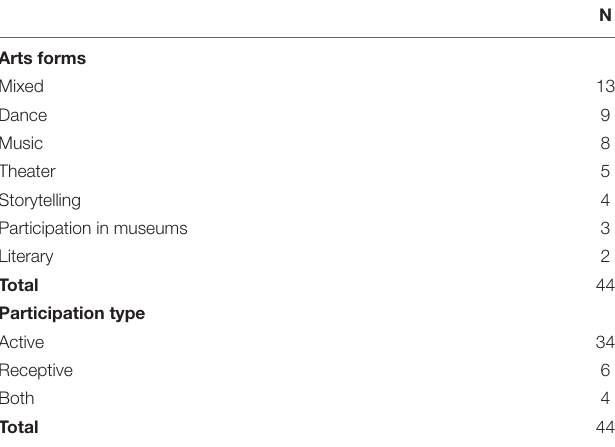
TABLE 3 | Arts forms and participation